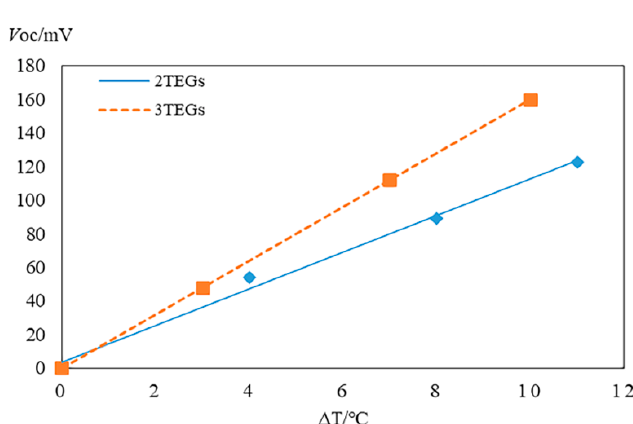
Figure 6. TEGs used in the experiment.